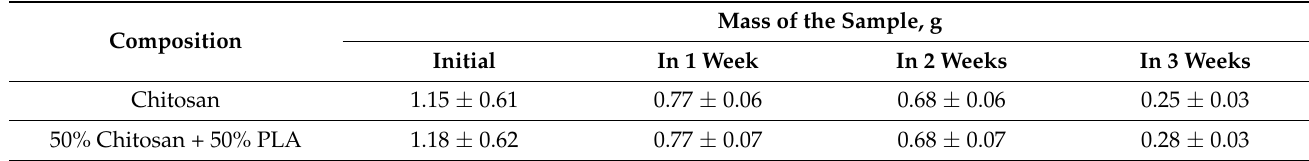
Table 7. Change in sample weight during